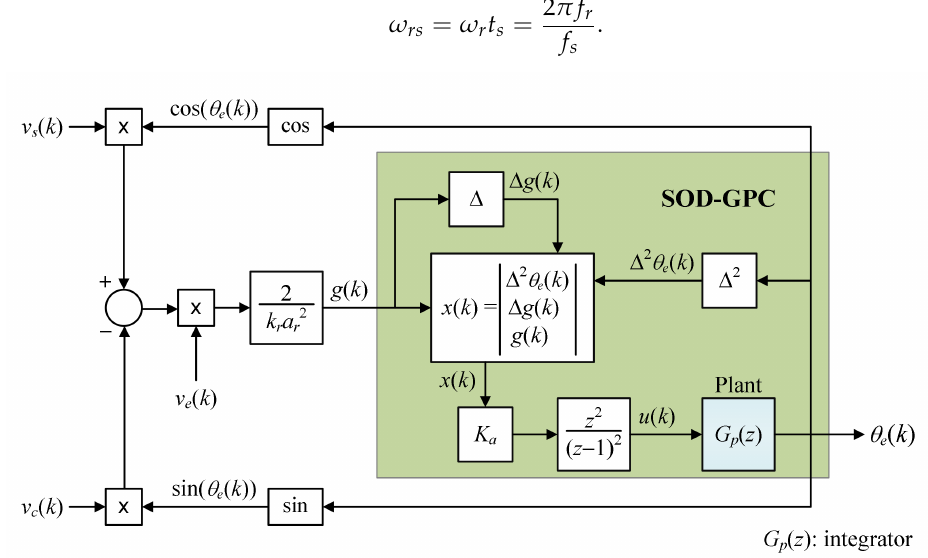
Figure 4. Proposed ATO based on the